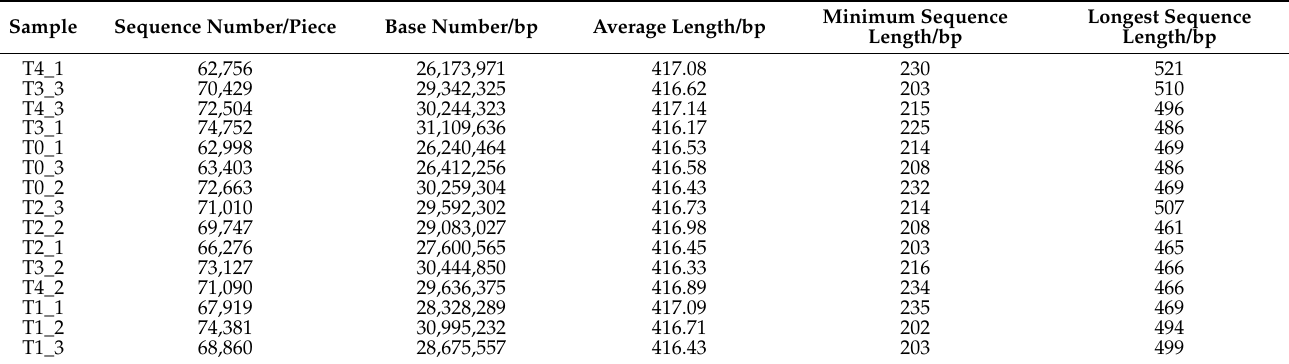
Table 1. Statistics of bacterial sample data.